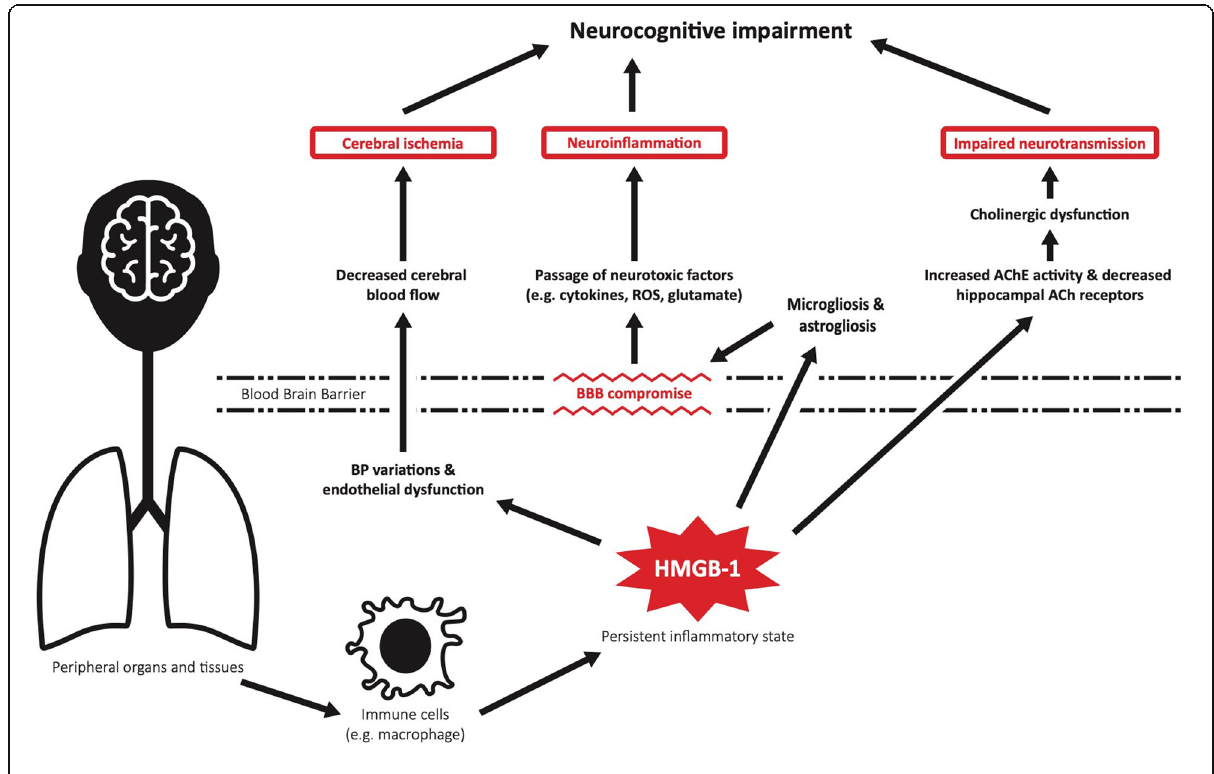
Fig. 4 Mechanisms of cognitive decline after sepsis. The neurocognitive effects of sepsis are caused by a combination of cerebral ischemia, neuronal dysfunction, and neuroinflammation. These three contributory pathways are associated with persistently elevated levels of HMGB1, a cytokine secreted by immune cells (e.g. monocytes, macrophages, and dendritic cells) during the late stages of sepsis. Systemic endothelial dysfunction and variations in blood pressure lead to poor blood flow to the brain and contribute to cerebral ischemia. Cholinergic dysfunction is related to increased acetylcholinesterase activity and a decrease in receptor density in the hippocampus; this pathophysiology is a major contributor to impaired neurotransmission. Activation of microglia and astroglia produce increased inflammatory mediators (tumor necrosis factor, interleukin-6, and interleukin-12) and is associated with compromised blood-brain barrier integrity that allows for the passage of neurotoxic factors (cytokines, reactive oxygen species, and glutamate) and sustained